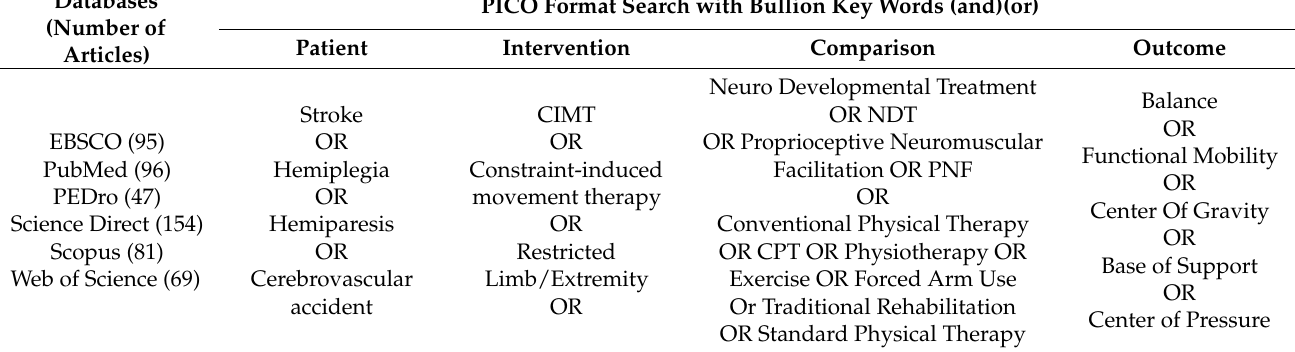
Table 1. Search strategy used in the